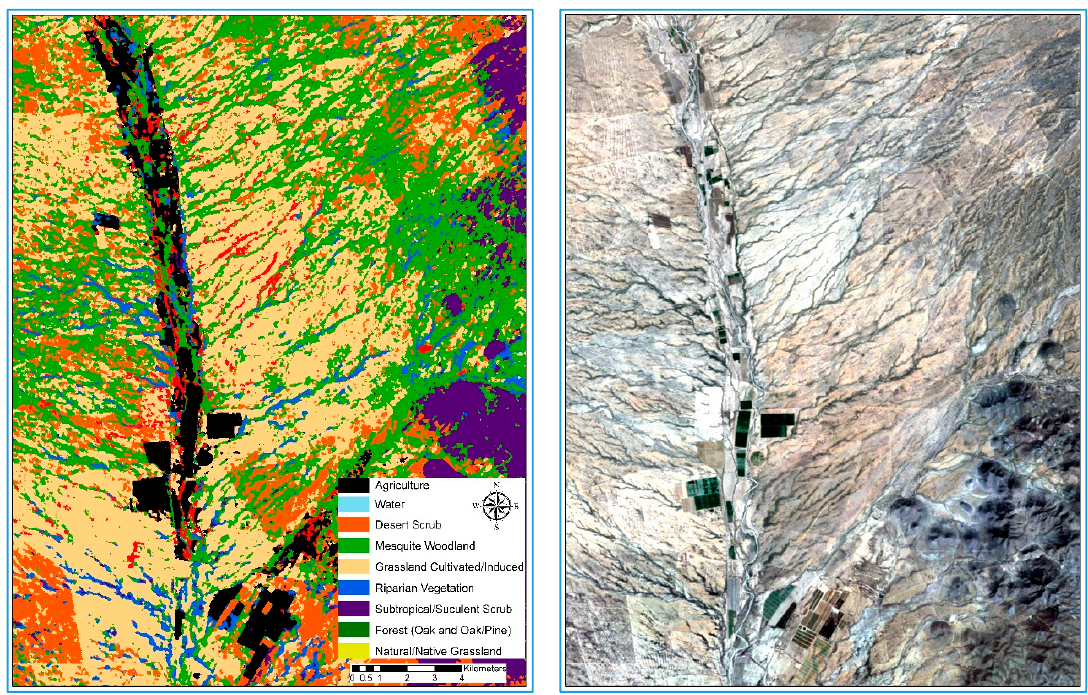
Figure 2. Thematic map ( left ) derived from the CART model using Landsat TM scene ( right ) sub-products and ancillary datasets. Table 4. Summary of the User’s, Producer’s, Kappa and Overall accuracies for the CART (Classification and regression Tree) based vegetation classifications for 1993, 2002 and